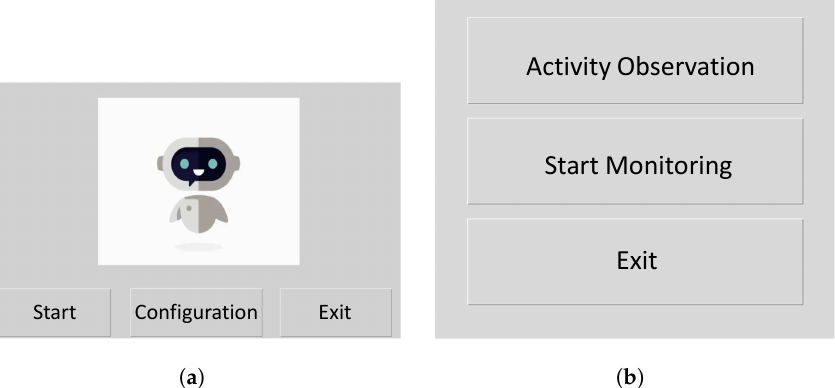
Figure 4. Different options in the developed graphical user interface for action monitoring. ( a ) gives options to specify the user ID and the actions to be monitored. There are options to choose from for observing and monitoring the action in ( b ). ( a ) Main menu. ( b ) Action monitoring